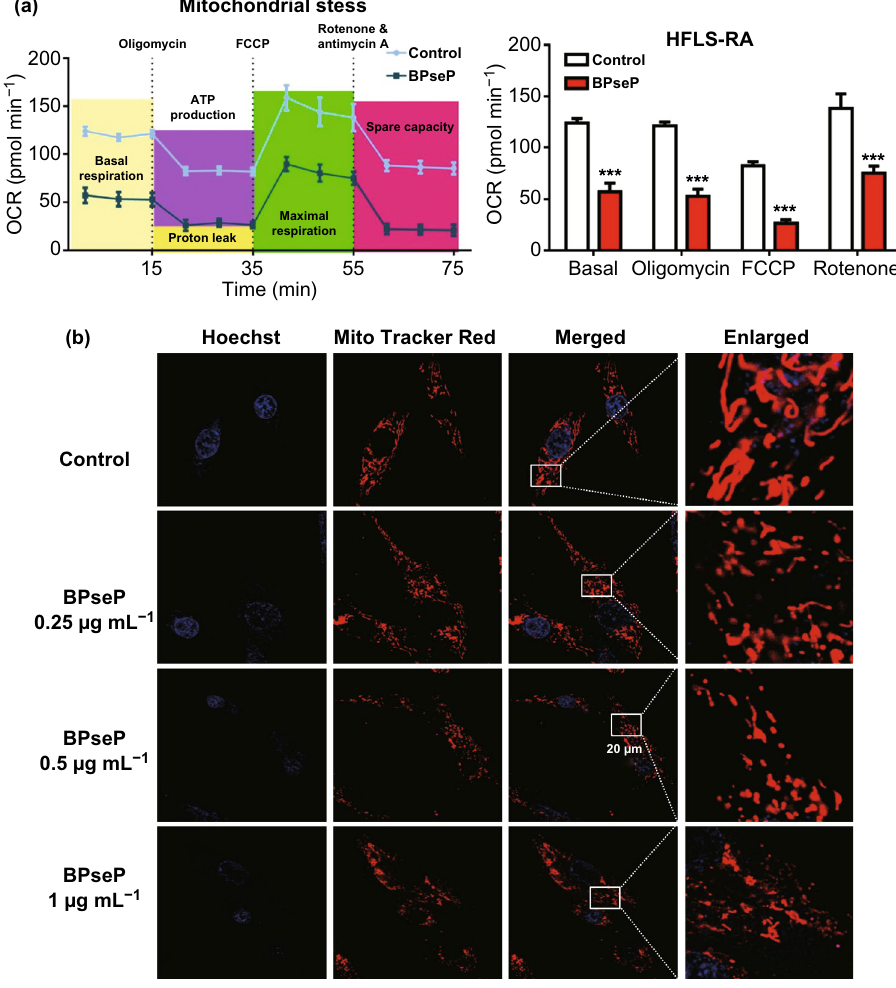
Fig. 5 a OCR was remarkably suppressed by BPsep in HFLS‑RA. b With the increasing concentration of BPseP, the morphology change of mitochondria became shorter and smaller. Data were analyzed as the mean ± SEM for triplicate individual experiments (* P < 0.05, ** P < 0.01, *** P <